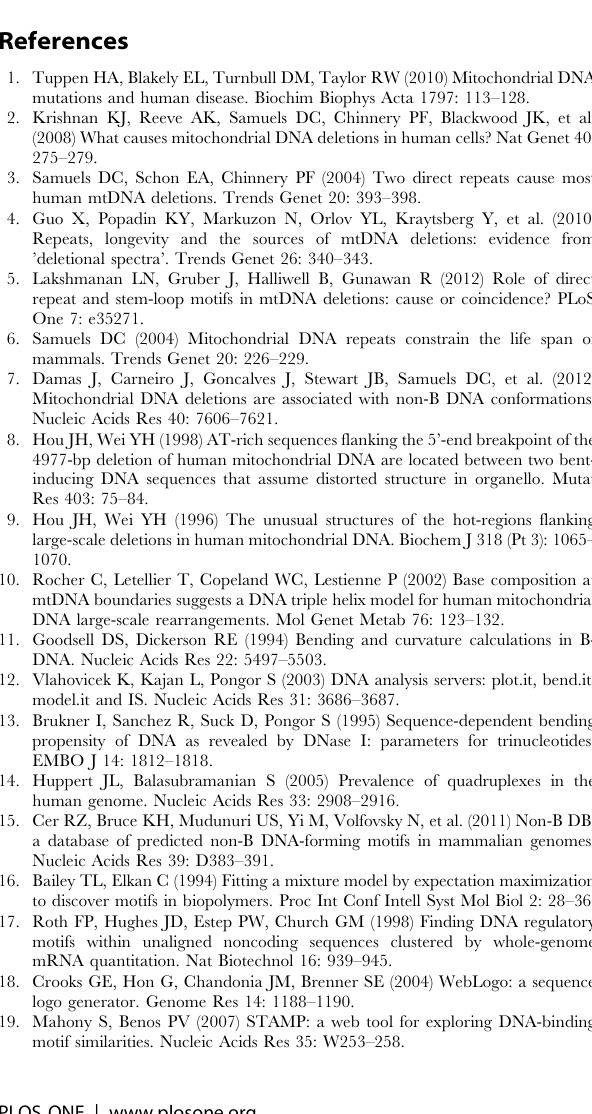
Figure S1 Three-dimensional reconstruction of the remaining 0.2 kb highly curved sequences highlighted in Fig. 2A. The exact position corresponding to each curvature maximum is highlighted in red. Figure S2 Sequence logos for the most significant motifs found in regions flanking ( 6 15 bp) deletion breakpoints using MEME and AlignACE. MEME E values correspond to the expected number of motifs with equal or